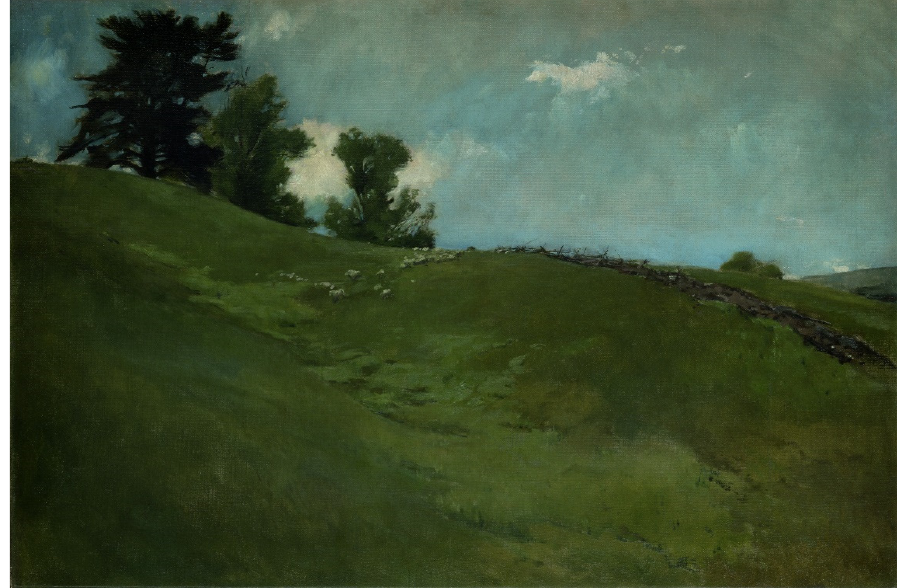
Figure 17. John White Alexander, Landscape, Cornish, N. H ., ca. 1890, oil on canvas, 77.2 × 114.2 cm, Smithsonian American Art Museum, museum purchase,